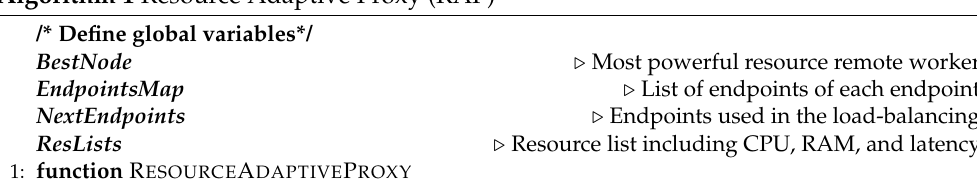
Algorithm 1 Resource Adaptive Proxy (RAP)